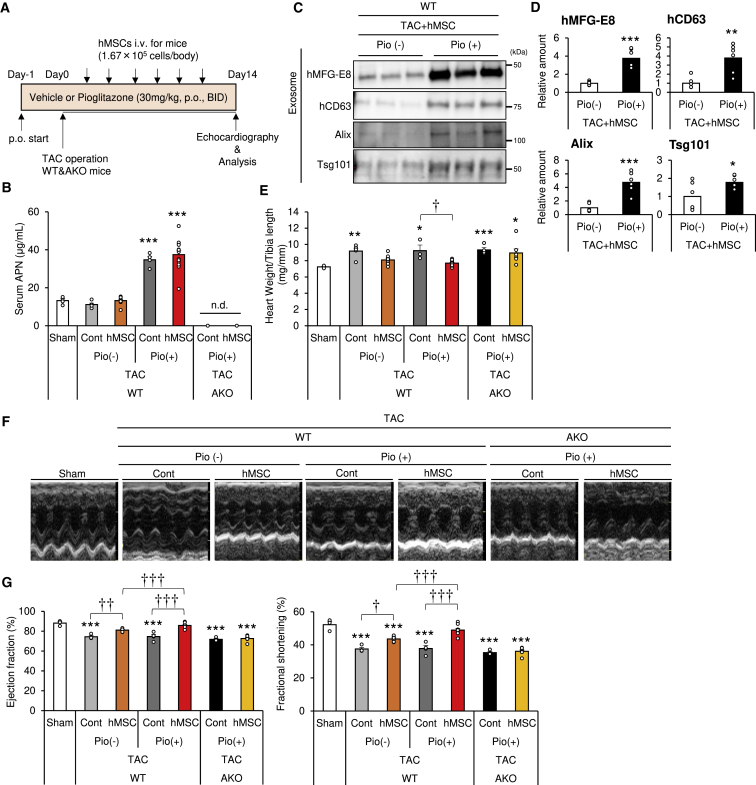
High Adiponectin Levels Augment the Cardioprotective Effects of hMSCs(A) Experimental design for hMSC intravenous injection and simultaneous oral (p.o.) administration of pioglitazone (Pio; 30 mg/mL, BID) into mice of the transverse aortic constriction (TAC) model. hMSCs were injected at a concentration of 1.67 × 105 cells per body via the tail vein. The injection was repeated 6 times at 2- to 3-day intervals within a period of 2 weeks. Echocardiography was performed at day 14. (B) Plasma adiponectin levels were analyzed by ELISA (n = 4–13). n.d., not detected. (C) Representative immunoblots. Serum exosomes from WT mice were subjected to western blot analysis with the indicated antibodies of exosome markers. (D) Exosome marker levels from western blots (n = 6). (E) Heart weight per tibia length ratio (n = 4–13). (F) Representative images of echocardiography. (G) Ejection fraction (EF) and fractional shortening (FS) at 2 weeks after TAC or sham surgery (n = 3–9). Data are mean ± SEM. ∗p < 0.05; ∗∗p < 0.01; ∗∗∗p < 0.001 versus sham. †p < 0.05; ††p < 0.01; †††p < 0.001 between groups, by one-way analysis of variance with post hoc Tukey’s multiple comparisons.